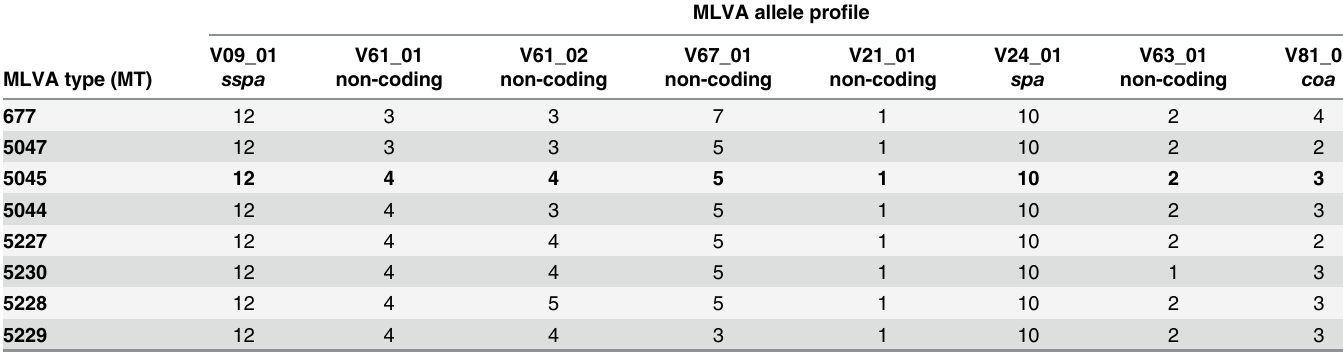
Table 2. Overview of all MLVA types and profiles identified in 194 ST8-MRSA-IV-t304-PVL negative isolates.